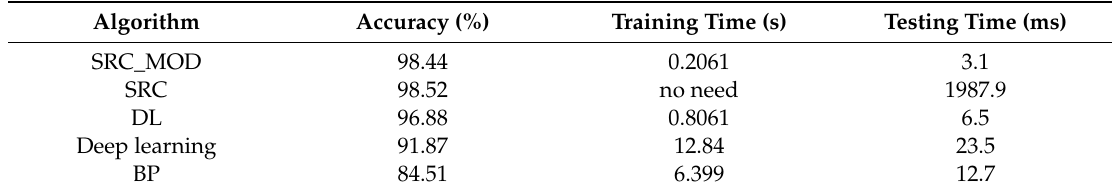
Table 2. Performance comparison with other